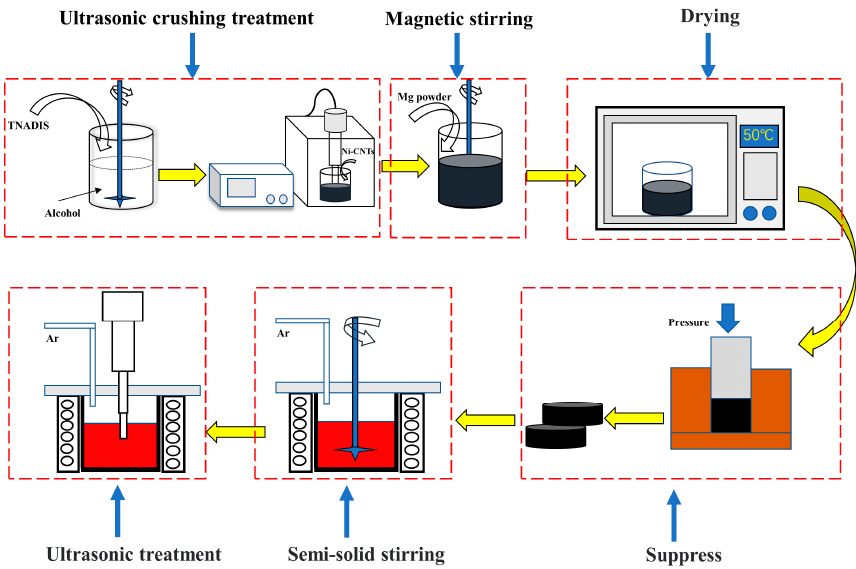
Figure 1. Schematic diagram of the preparation of Ni-CNTs/AZ91 magnesium matrix composites.